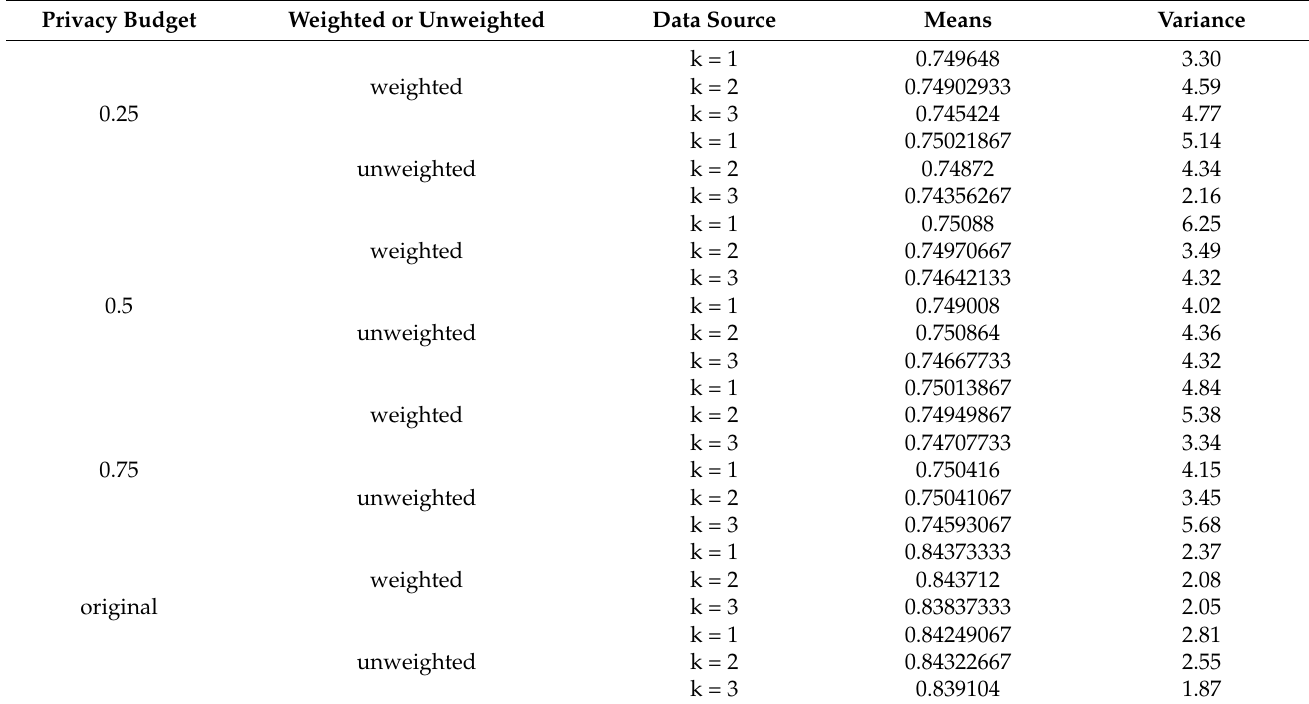
Table 1. The performance of the initial global model H 0 in the t 1